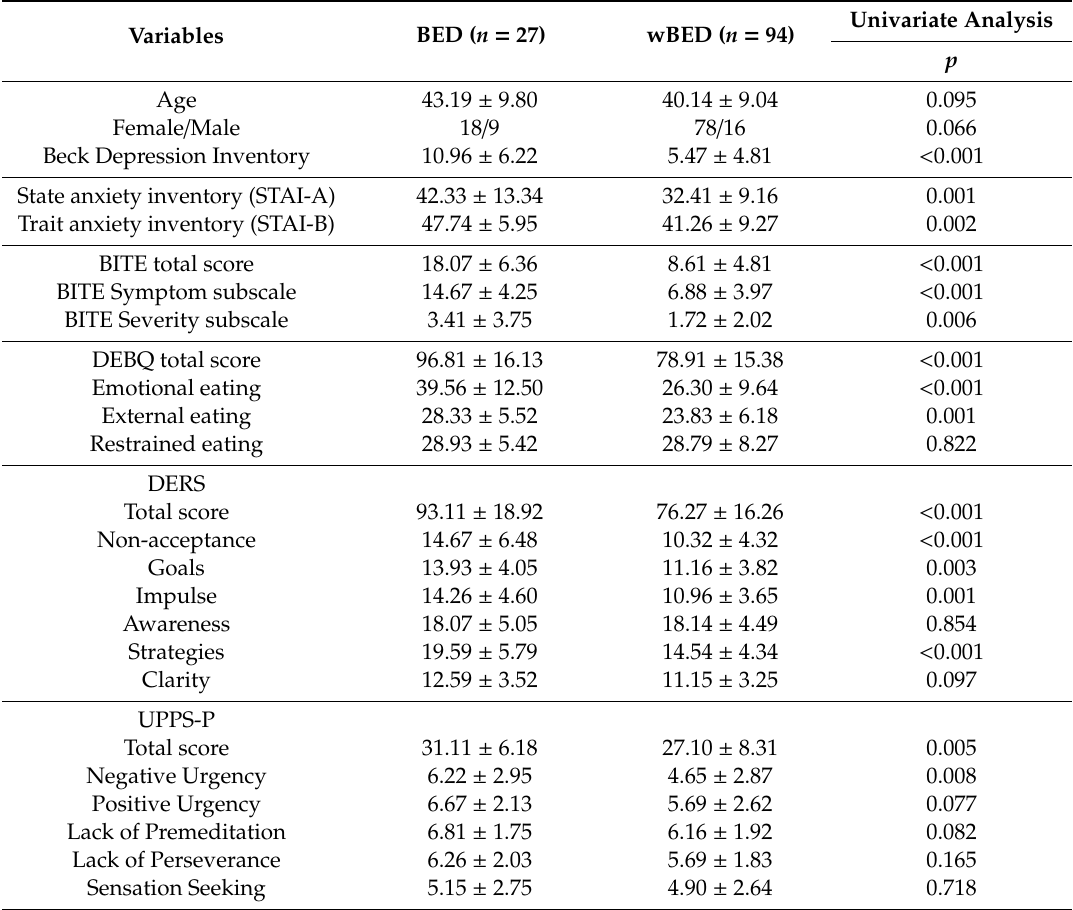
Table 1. Comparison of sociodemographic and clinical characteristics in obese adults seeking bariatric surgery using univariate analyses (with binge eating disorder (BED) and without BED